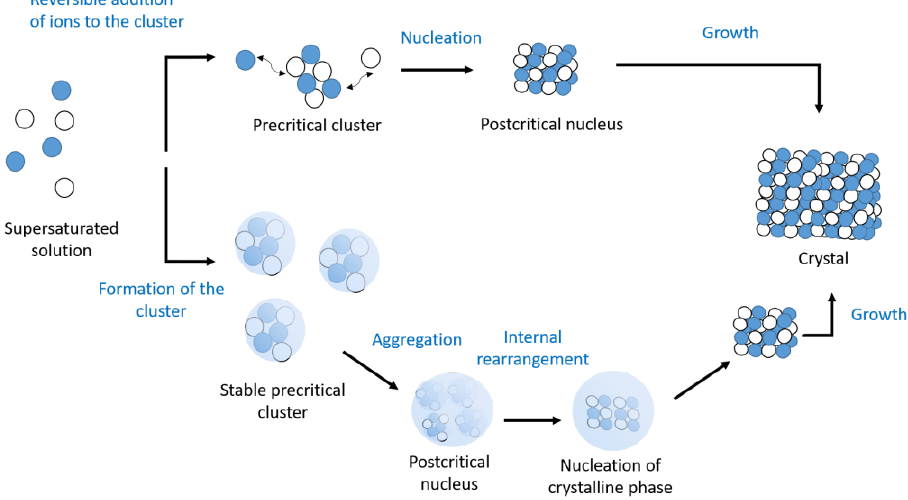
Figure 11. Schematic view of the different steps proposed by both classical and non-classical theories. Adapted from [45].